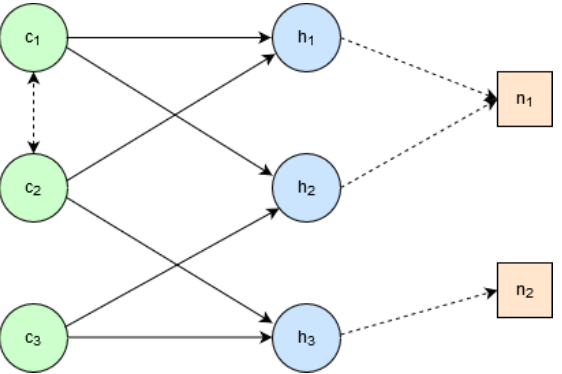
Figure 2. A bipartite graph representation of the component deployment